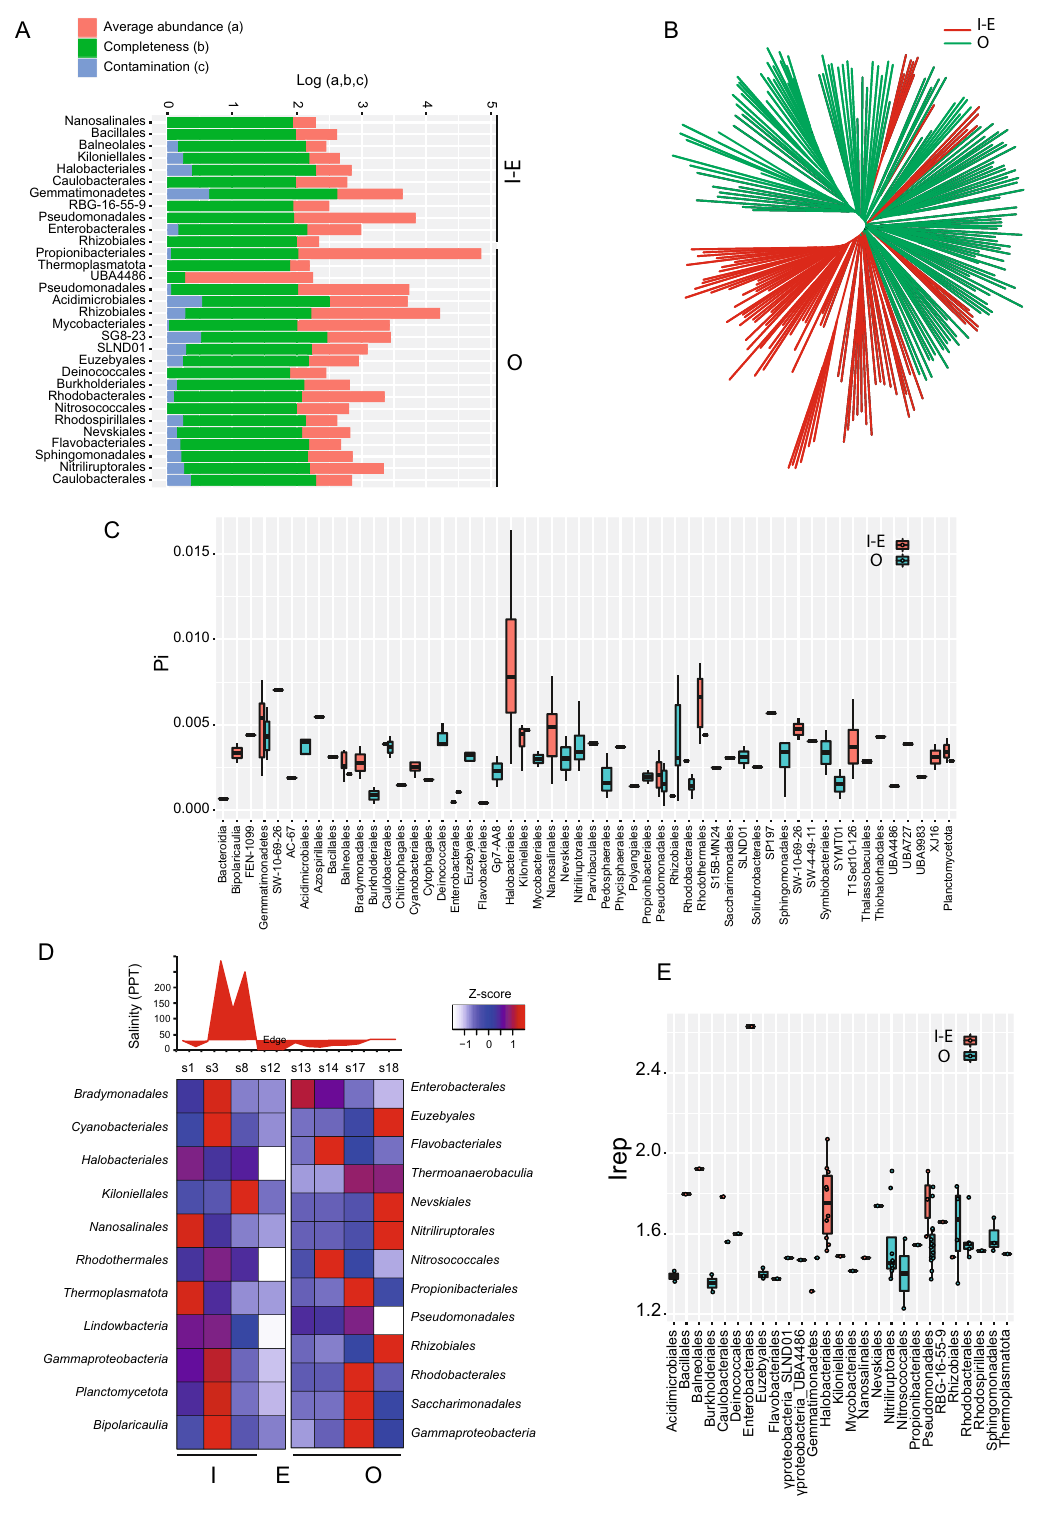
Figure 4. Whole metagenome resolved genome assemblies’ analysis. ( A ) Barplot of the 225 whole metagenome resolved genome assemblies across the different taxonomic order level, plotted by logarithm of completeness, abundance, and contamination. ( B ) kmer-based phylogenomic tree of inside and outside sabkha. ( C ) Nucleotide diversity (Pi) for the different taxonomic order level of inside and outside sabkha. ( D ) Salinity as parts per thousand (PPT) plots across inner and outer sabkha (top panel). Dereplicated genomes for inner and outer sabkha with minimum 1% abundance across sites samples per population, which represented by a Z-score of the mean (bottom panel). ( E ) Replication index (Irep) for the mapped reads to the actual representative genomes, where value above 1 represent the percentage of replicating cell in the population (e.g., 1.2, means 20% of cells are